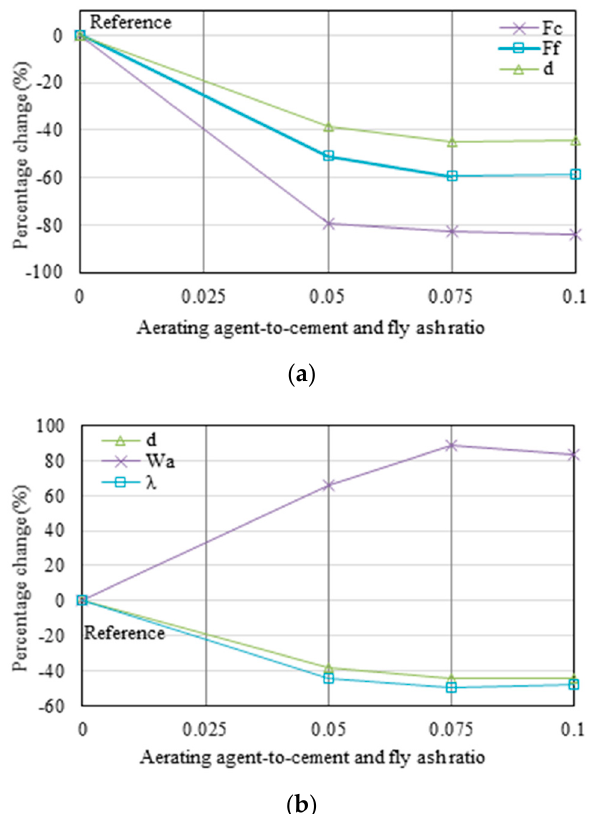
Figure 9. Percentage change in ( a ) F c , F f , and d; ( b ) d, W a , and λ , for the three levels of aerating agent to cement and fly ash ratio (0.05, 0.075, and 0.1) compared to the reference mixture (no aerating agent addition).